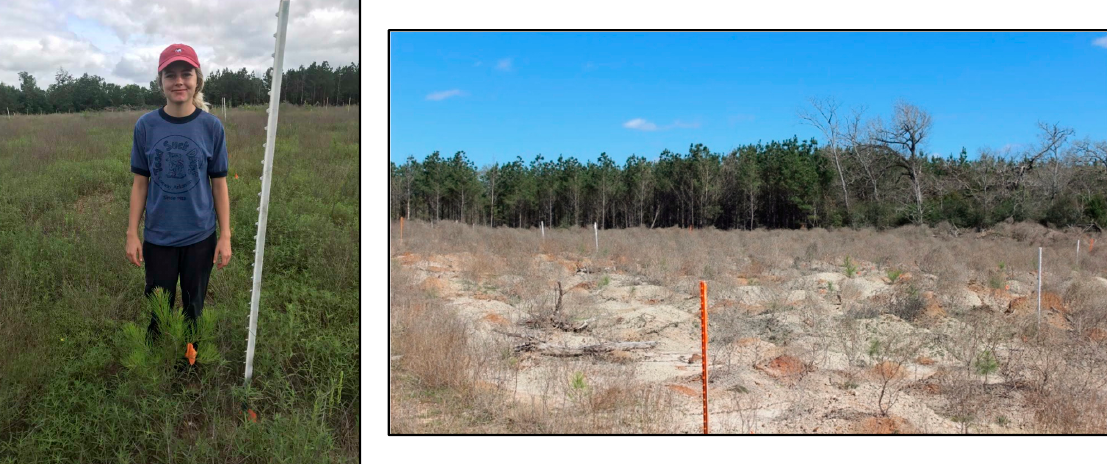
Figure 3. A photo taken in June 2017 of a scraper plot ( left ) contrasted with a photo taken in January 2017 of FRA style reclamation plots showing uncompacted loose soil piles ( right ).